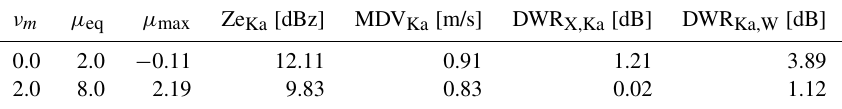
Table 1. Size distribution parameter for µ m = 1 / 3, the mass–size relationship of the Mix2 particles (Table 2), q = 2 × 10 − 4 kgm − 3 , and N = 10 4 m 4 (same as Fig. 2). Ze Ka , MDV Ka , and DWR X,Ka are calculated using the self-similar Rayleigh–Gans approximation (SSRGA) and the SSRGA parameters of Mix2 as provided by Ori et al. (2021). µ max is estimated by the zeroth, third, and sixth moment of the